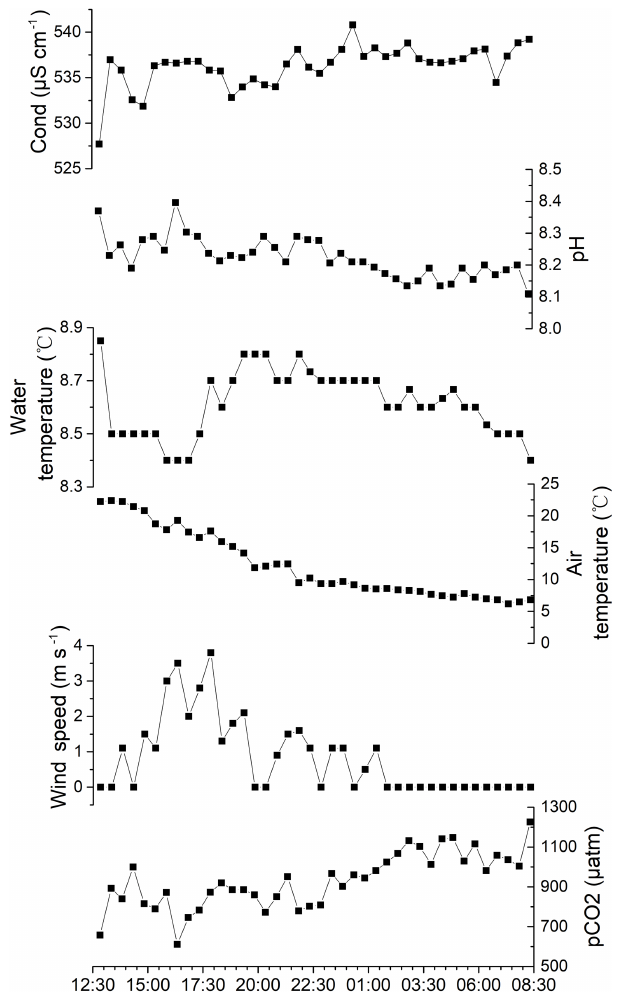
Figure 6. Diurnal variation in the water environment (including conductivity, pH, water temperature and total alkalinity), atmo- spheric environment (air temperature and wind speed) p CO 2 and efflux.